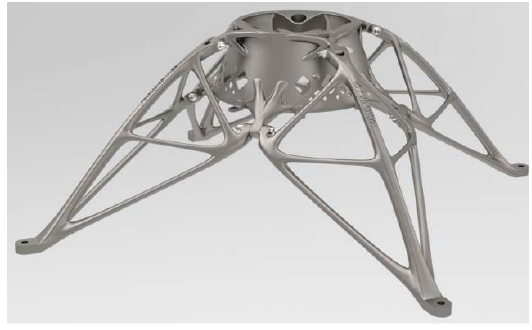
Figure 18. Rendering of final topologically optimized design.